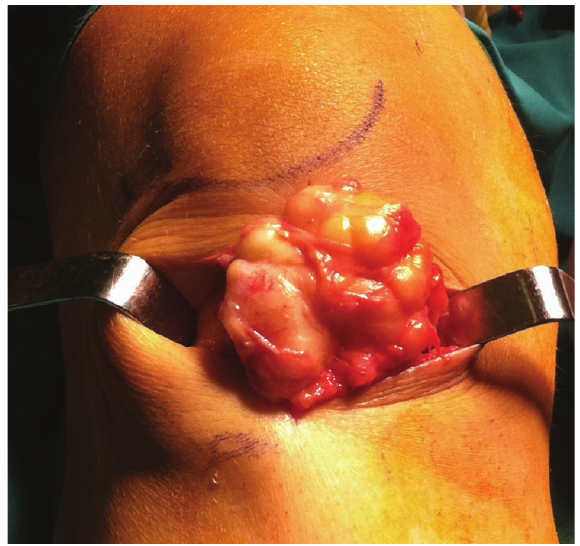
Figure 5: Intraoperative image showing the mass before its final excision.